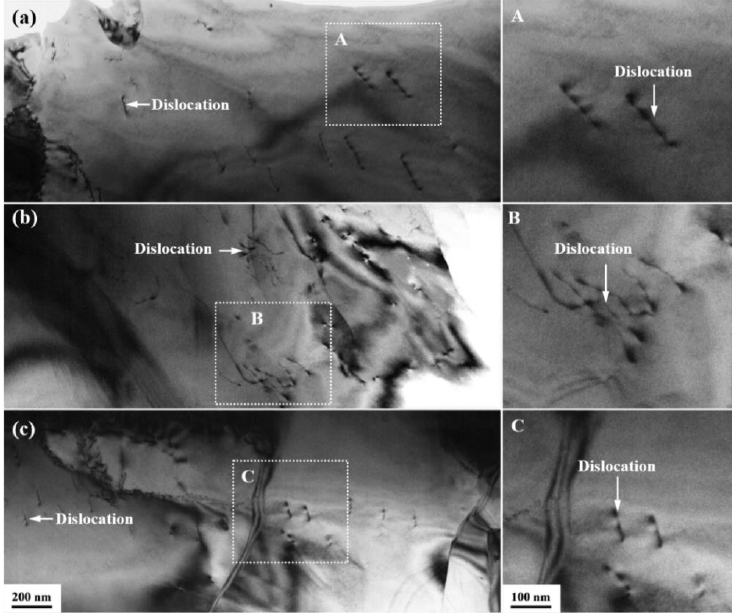
Figure 7. Dislocations in the TEM micrographs of ( a ) R1 alloy, ( b ) R2 alloys and ( c ) R3 alloys and A – C are local enlarged images of ( a – c ) respectively.